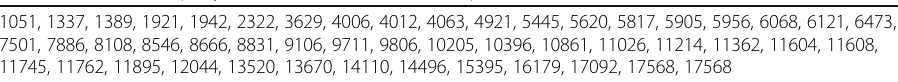
Table 8 Kevlar 49/epoxy strands failure times data (pressure at